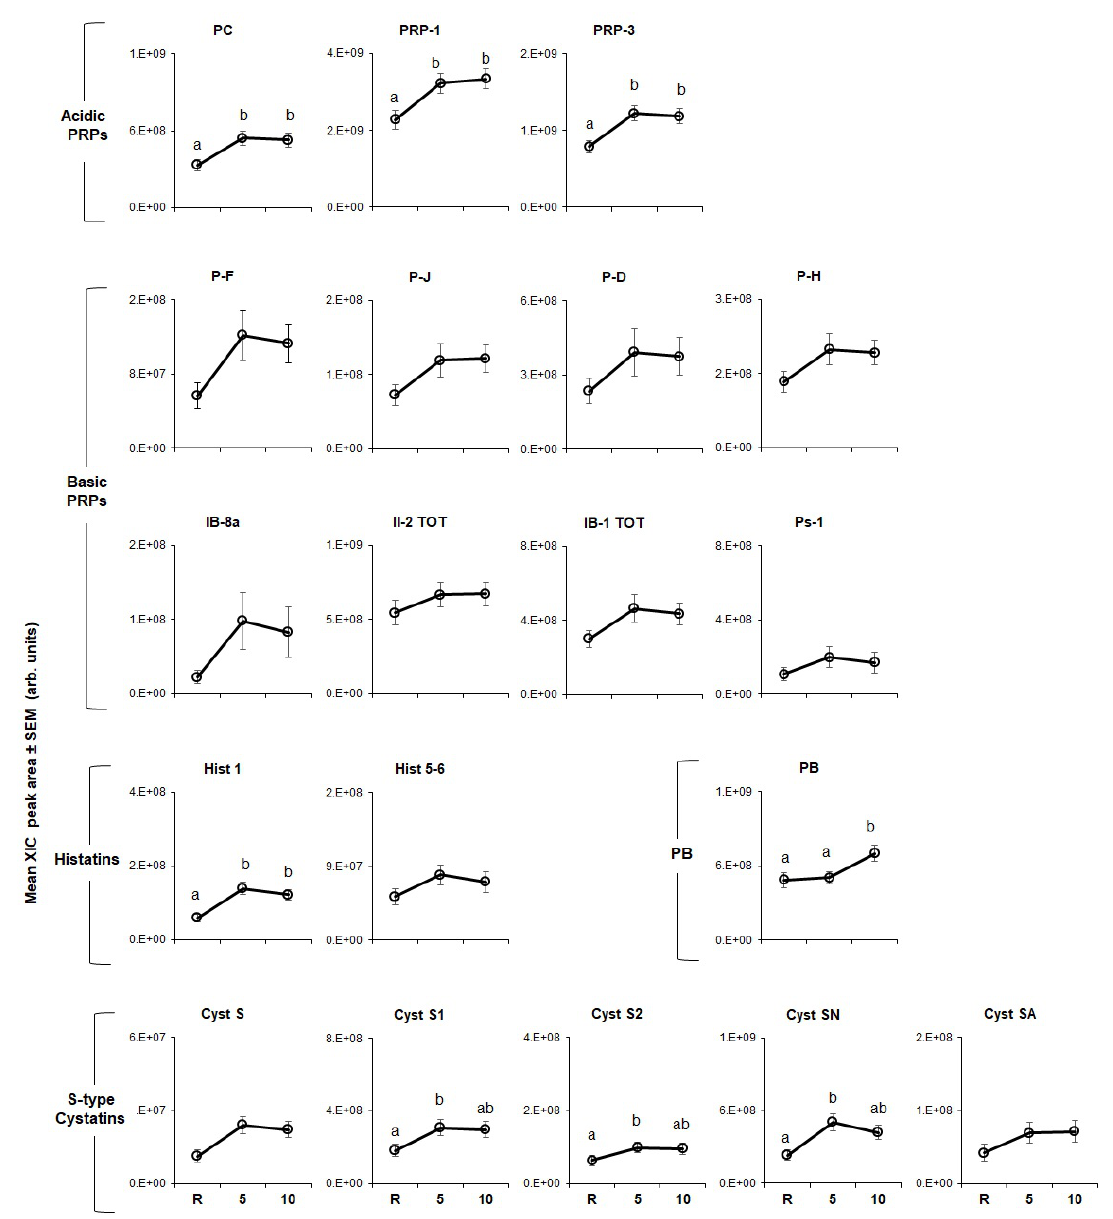
Figure 5. E ff ect of stimulation with CPE on levels of individual salivary proteins. Mean extracted ion current (XIC) peak area ± SEM ( × 10 8 arbitrary units) of individual proteins measured at resting (R), 5 min (5) and 10 min (10) after stimulation ( n = 60). Means within protein type with di ff erent superscript letters (a, b) are di ff erent at p <